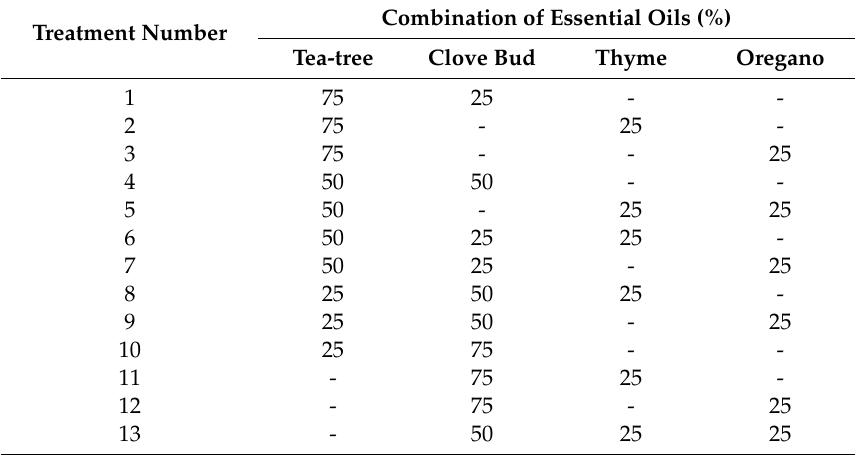
Table 1. Treatments and combination of essential oils evaluated in in vitro